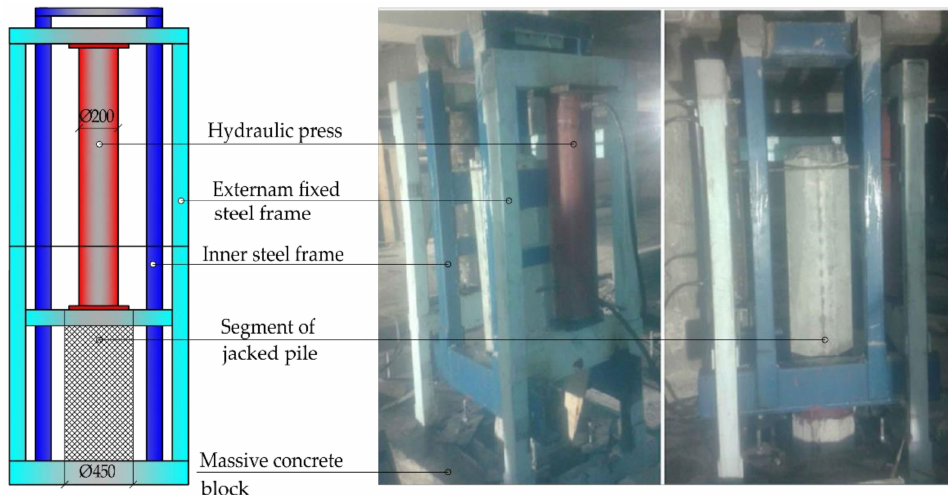
Figure 2. Steel frame with the hydraulic press for pile